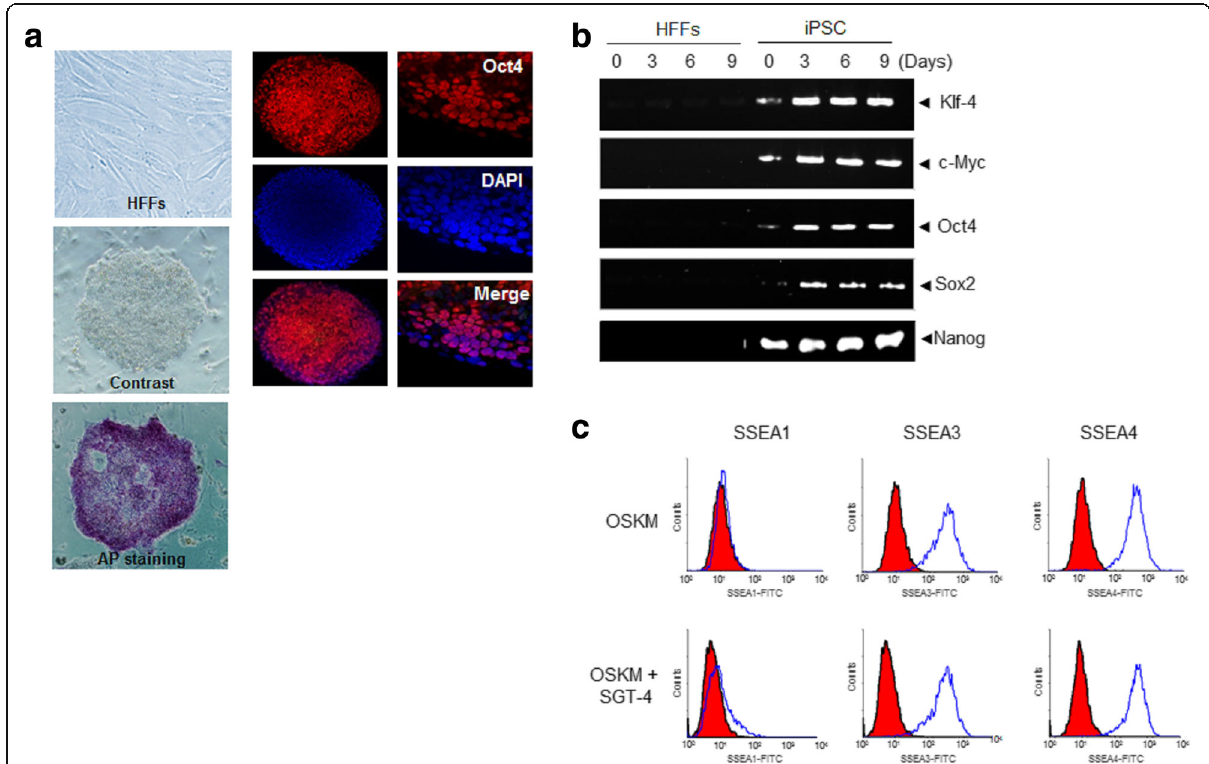
Fig. 2 Generation and characterization of HFF-derived hiPSCs. a Typical morphology of human foreskin fibroblast (HFFs). Phase contrast, AP staining and immunostaining of the pluripotent-associated marker Oct4; Counter-staining with DAPI. b RT-PCR results demonstrated that three randomly selected 2F HFF-iPSC colonies expressed the pluripotent marker genes KIf4, c-Myc, Oct4, Nanog, and Sox2. c FASC analysis of the colonies differentiated into HFF-derived iPSCs in the present of SGT-4 on day 9 after transfection hiPSC markers including SSEA1, SSEA3, and SSEA4